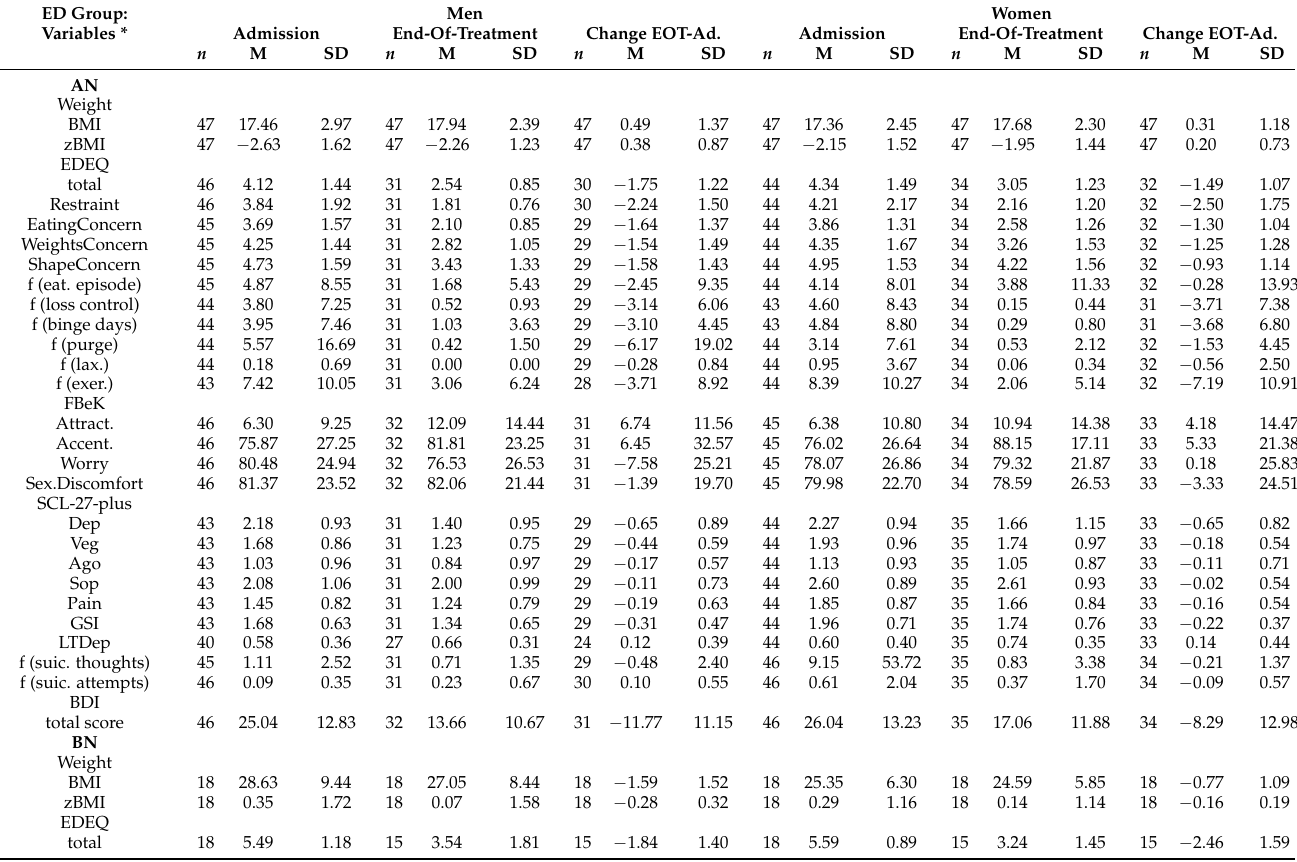
Table A1. Outcome measures descriptive